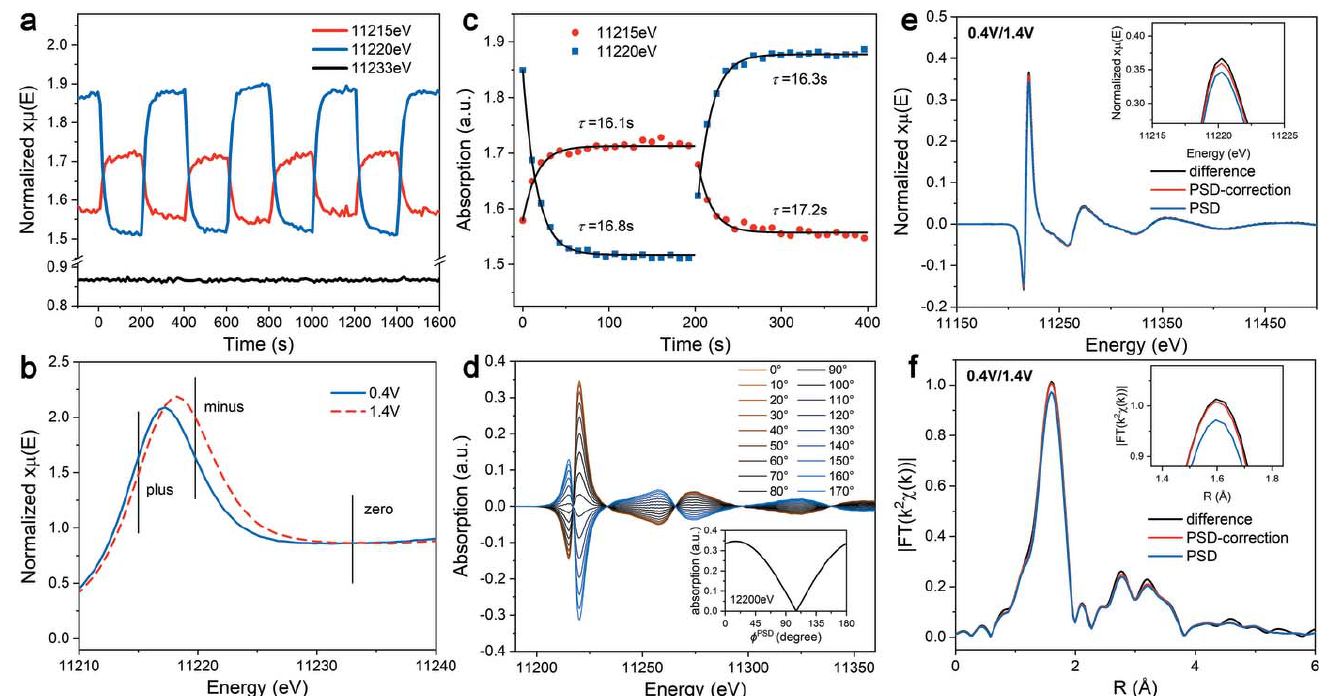
Figure 5 ( a ) Absorption coefficient changes with time at selected energy points. ( b ) Reconstructed original spectrum of two potentials and energy points selected. ( c ) The exponential fitting of the time response of the coordination coefficient with a square-wave excitation at different energy. ( d ) The PSD analysis of the phase lag induced by the relaxation of the system. ( e , f ) Comparison of the corrected and uncorrected PSD demodulated spectrum and the classical difference spectrum.